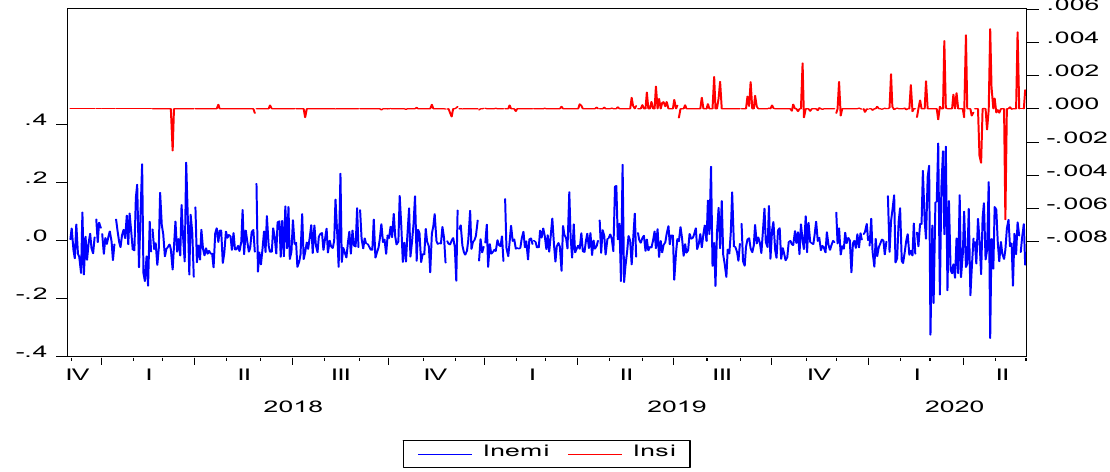
Figure 1. Daily returns of Emerging market and Saudi Sukuk indices prices.